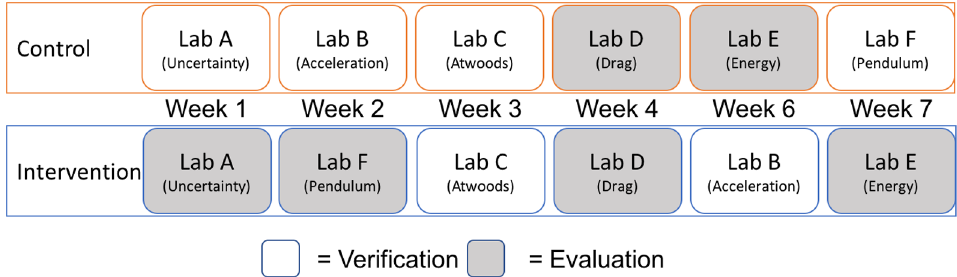
FIG. 2. Summary of the timing and types of labs throughout the courses. In verification labs, student investigations aimed to verify (demonstrate) a particular phenomenon or obtain a particular result (such as an estimate for acceleration due to gravity), implying low available epistemic agency. In evaluation labs, student investigations did not have any intended outcomes and students often had to collect data to evaluate multiple plausible models, implying high available